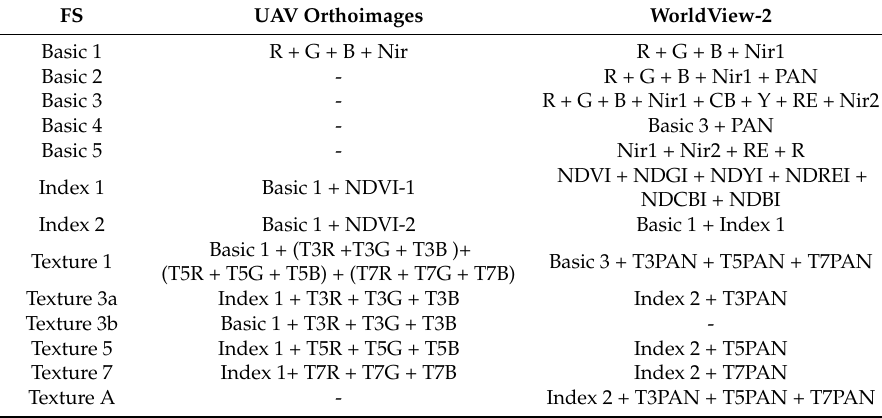
Table 2. Set of spectral bands, indices and textures which define each feature space (FS). Notes: for Unmanned Aerial Vehicle (UAV) imagery, bands R, G, B belong to the RGB orthoimage and the Nir band to the NIrRG